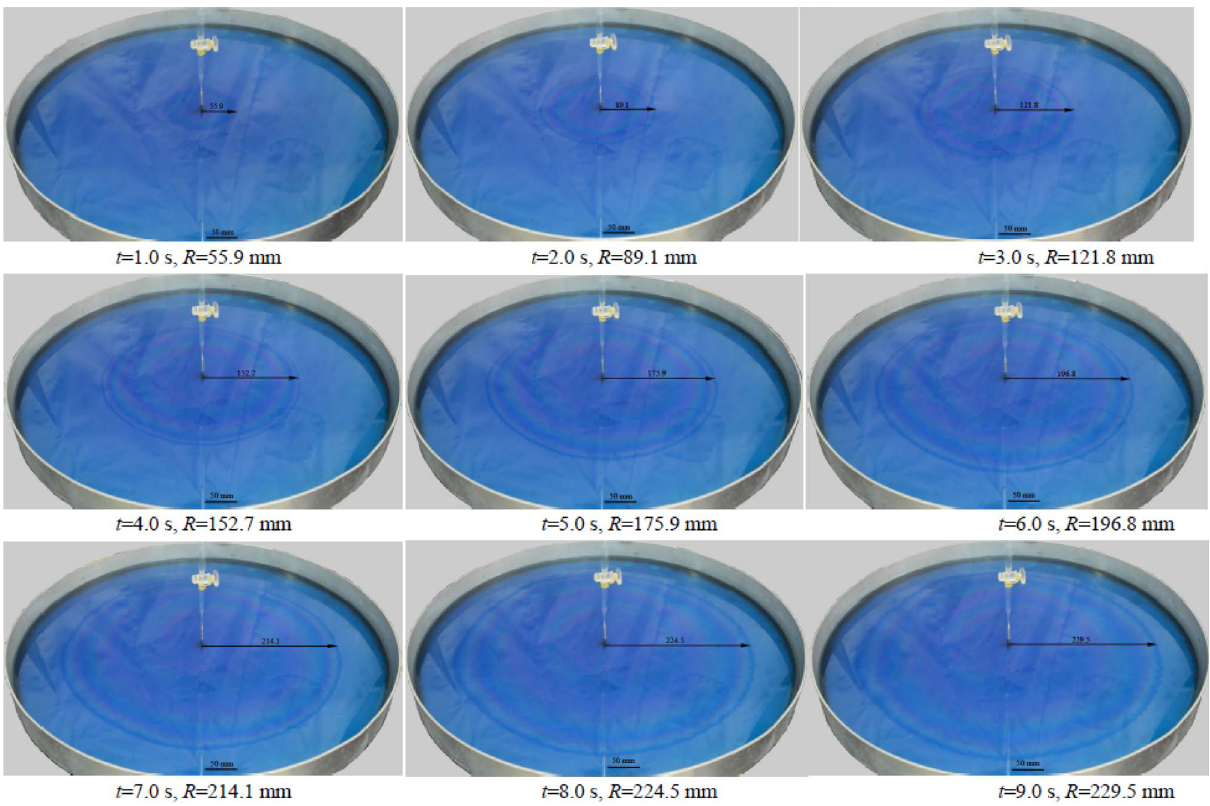
Figure 4. The actual spreading scenes of aqueous film formed by C4-Br/CH 3 (CH 2 ) 5 NaO 3 S solution spread on the surface of cyclohexane at different times at 25 °C.